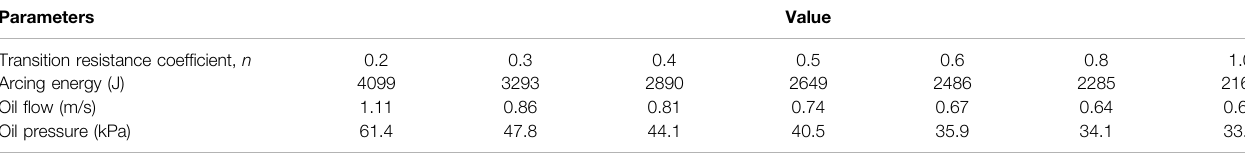
TABLE 2 | Oil fl ow velocity and oil pressure under different transition resistors. Parameters Value Transition resistance coef fi cient, n